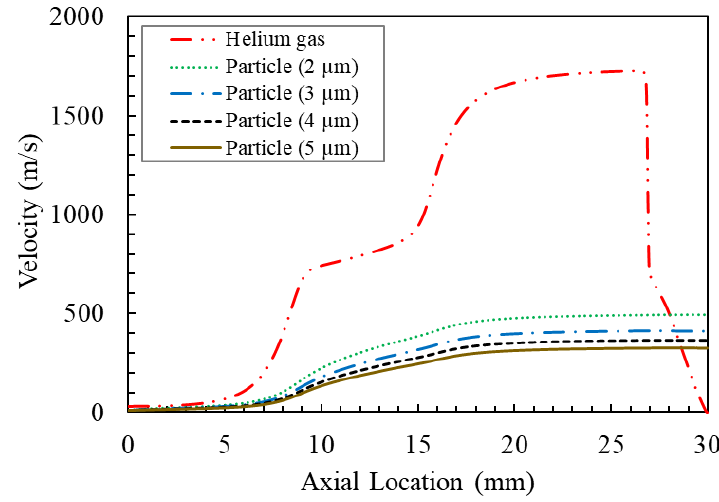
Figure 18. Effect of particle size on centerline particle velocity, T = 300 K.